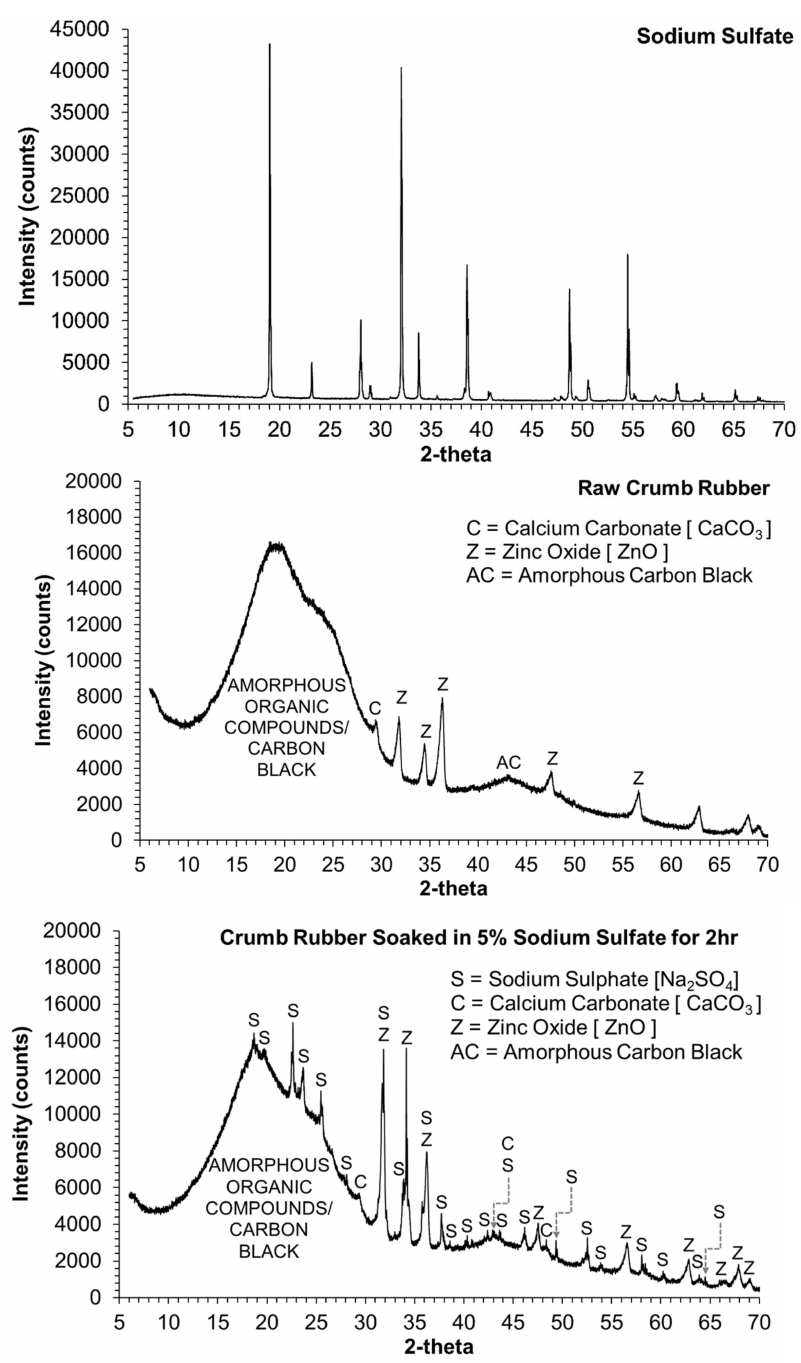
Figure 4. XRD diffractograms of: GBC, sodium sulphate, raw crumb rubber, and crumb rubber soaked in 5% sodium sulphate solution for 2